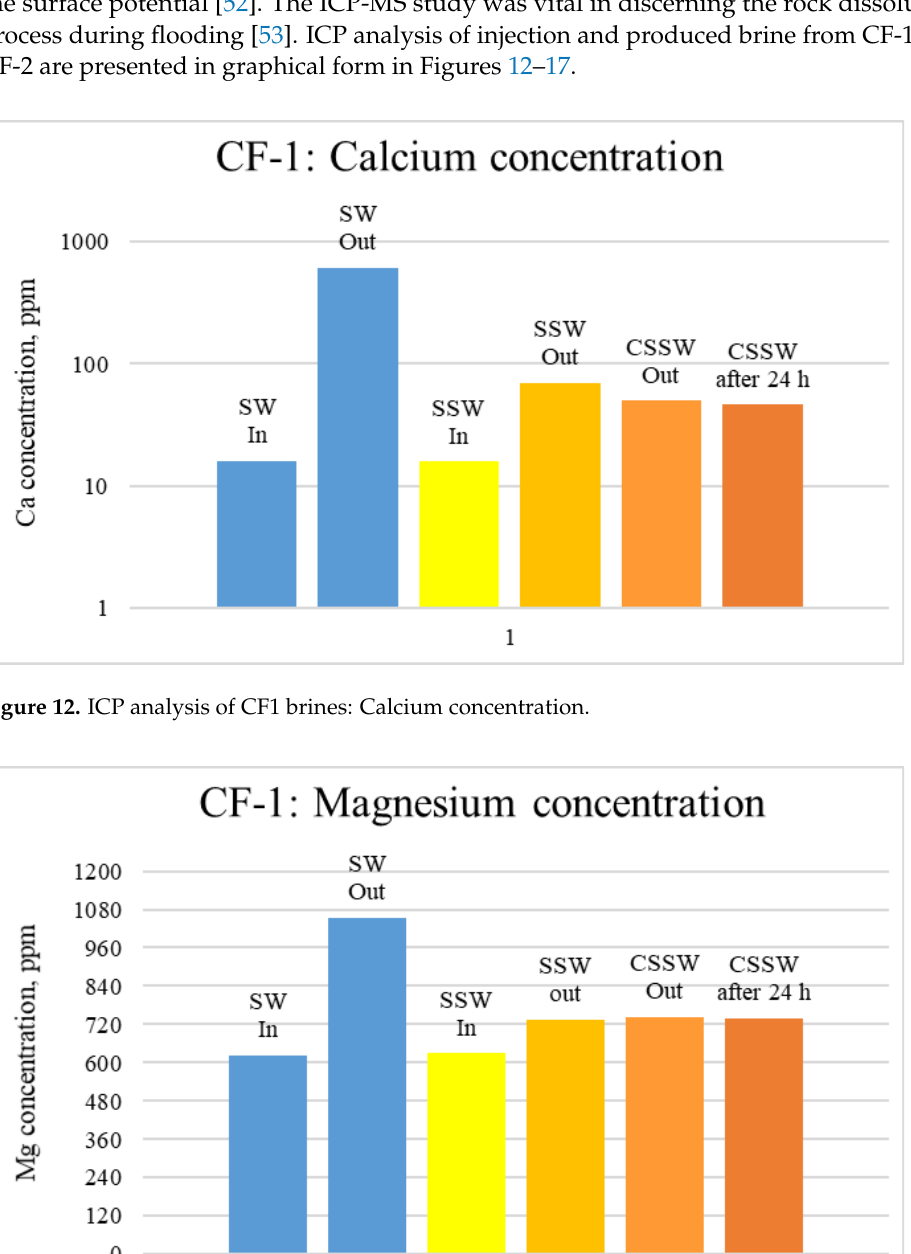
Figure 14. ICP analysis of CF1 brines: Sulfur concentration.